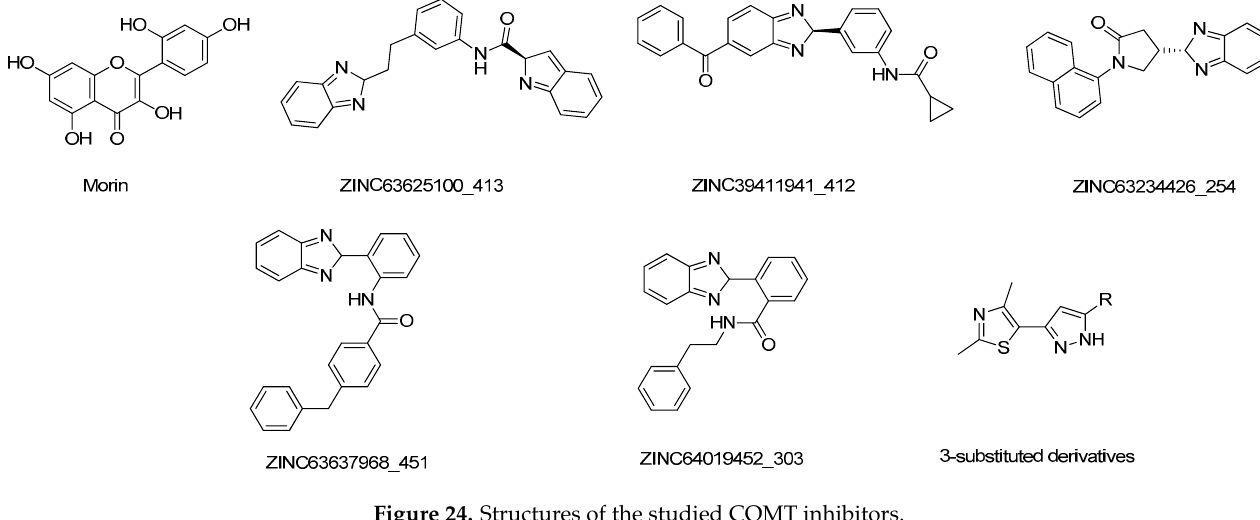
Figure 24. Structures of the studied COMT inhibitors.